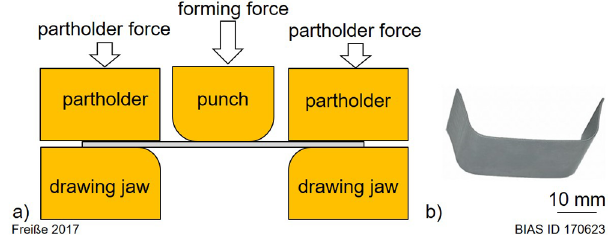
Fig. 2. (a) Sketch of strip drawing with bending. (b) Bended strip as a U-shaped component.